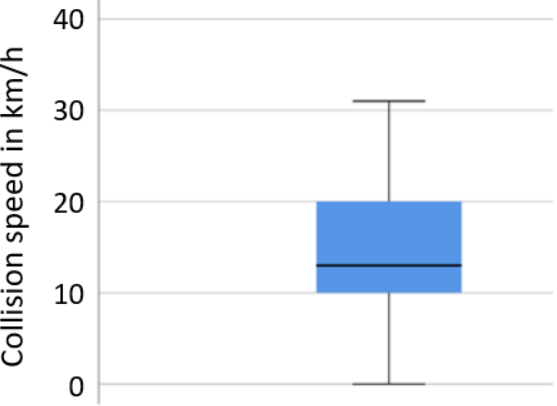
Figure 10. Scenario 2, collision speed of truck in right turn crashes, based on GIDAS.